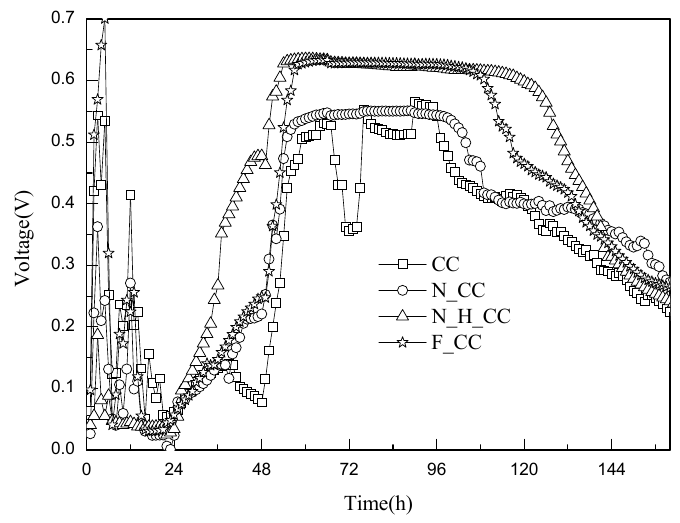
Figure 5. Working voltage of MFCs.